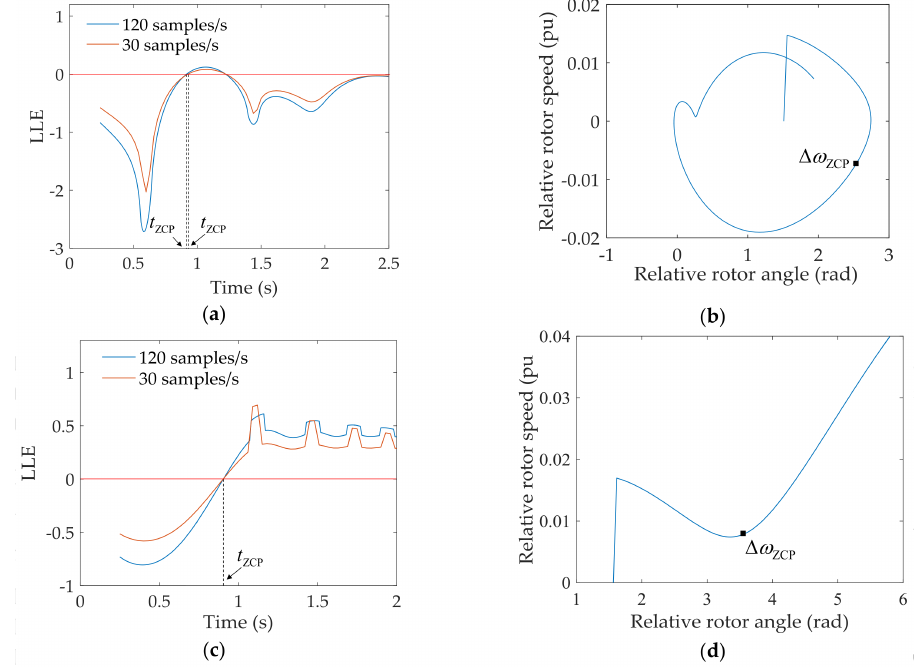
Figure 13. Simulation results of different sampling rates for Case 1 and Case 2. ( a ) LLE–time curves for Case 1; ( b ) phase-plane trajectory after clearing the fault of Case 1; ( c ) LLE–time curves for Case 2; ( d ) phase-plane trajectory after clearing the fault of Case